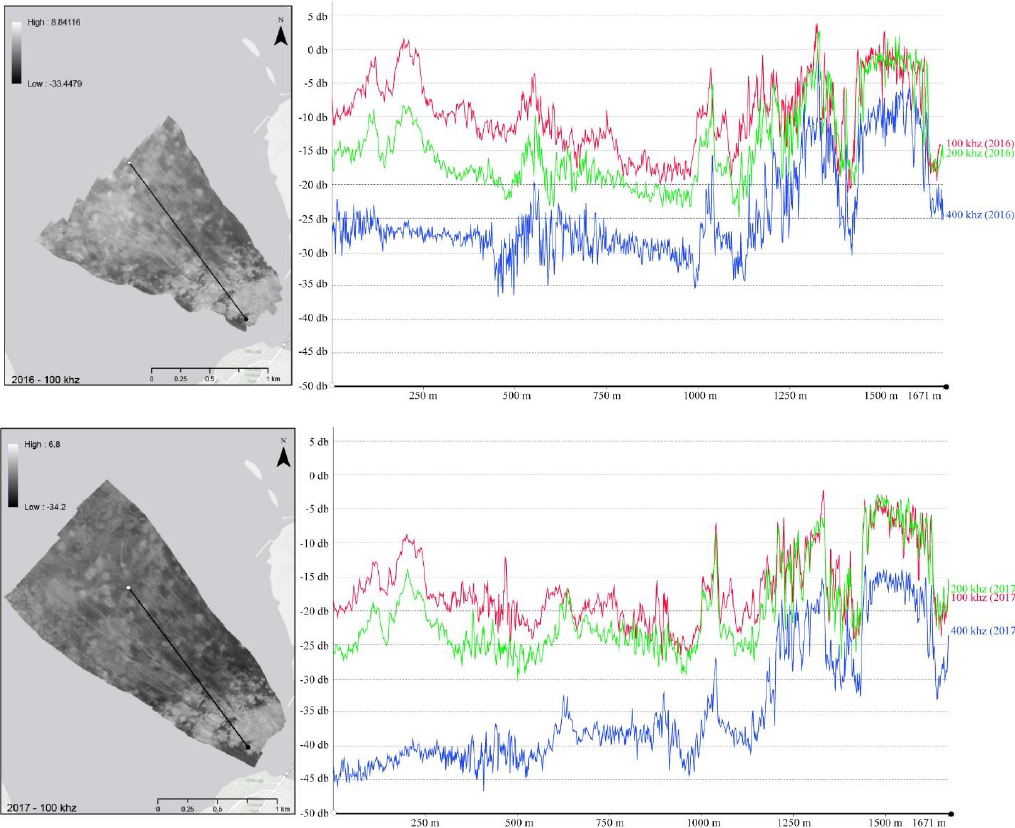
Figure 9. Top: 2016 data set. Bottom: 2017 data set. Comparison of differences in backscatter intensities within the survey site between the multispectral mosaics. Backscatter intensities from the three multispectral mosaics are compared along the transect shown on the 100 kHz mosaic (left). Backscatter intensities are similar in the hard-substrate region at the mouth of the narrows (SE of the site), and differences are visible in deeper water that is associated with the dredge spoil deposits.